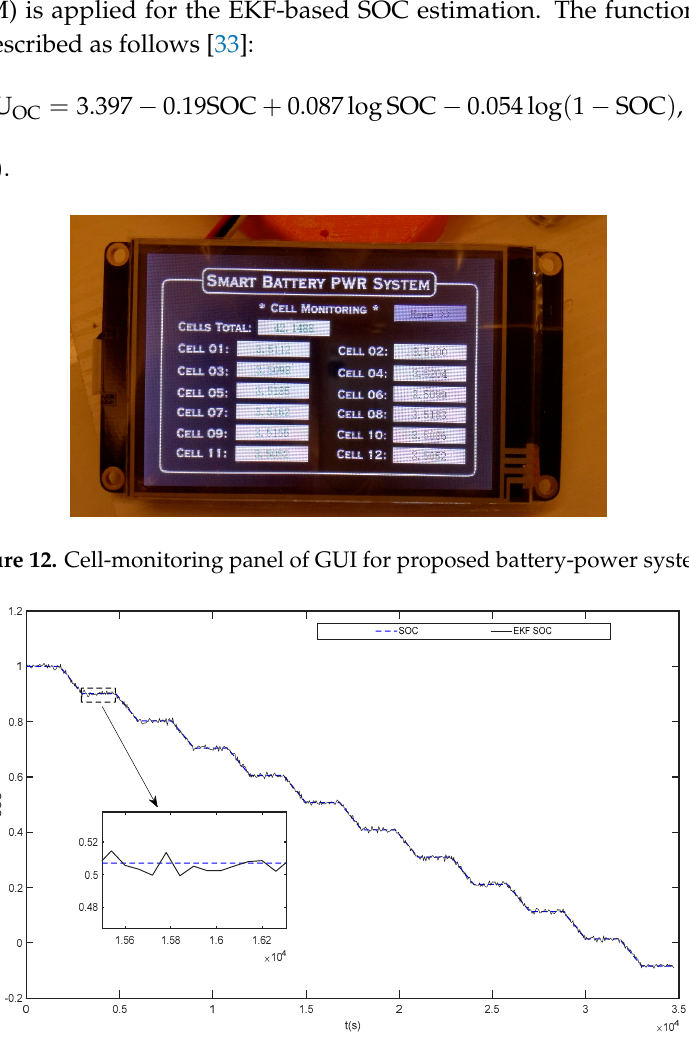
Figure 11. Configuration page of GUI for proposed battery-power system.